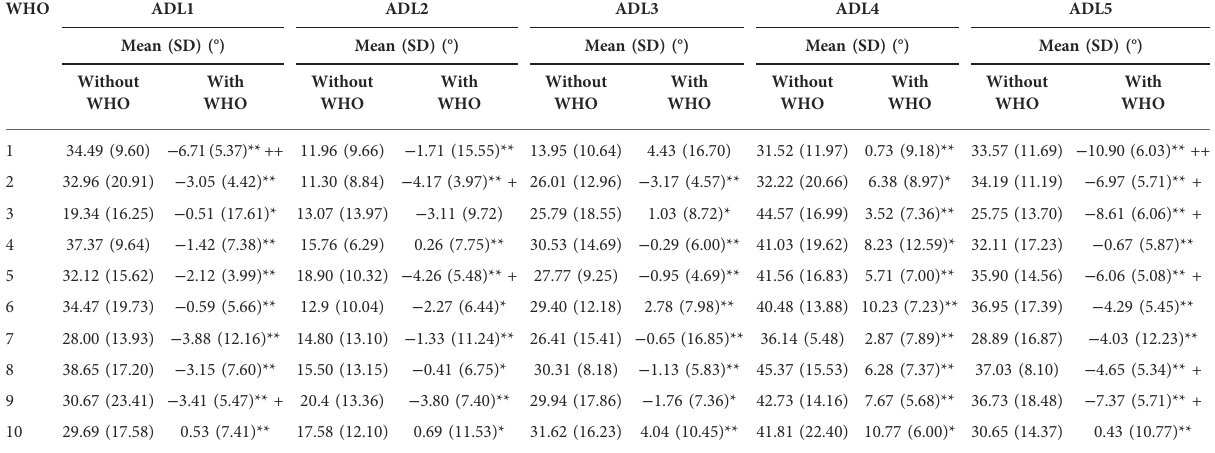
TABLE 3 Mean maximum fl exion with and without WHOs by